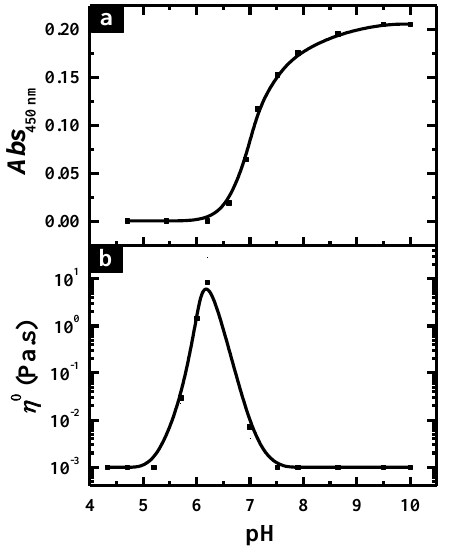
Figure 6. ( a ) Turbidity and ( b ) zero-shear viscosity η o of C 12 C 3 C 12 (SO 3 ) 2 /CTAB solutions plotted against pH at X g = 0.30 and C T = 20.0 mM.